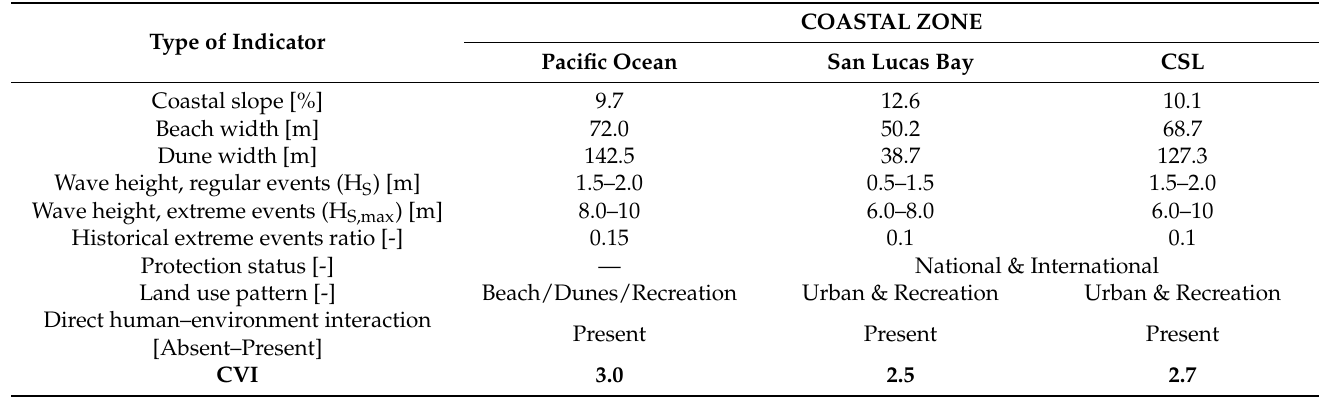
Table 3. Mean values for CVI assessment at Cabo San Lucas, the Pacific, and San Lucas